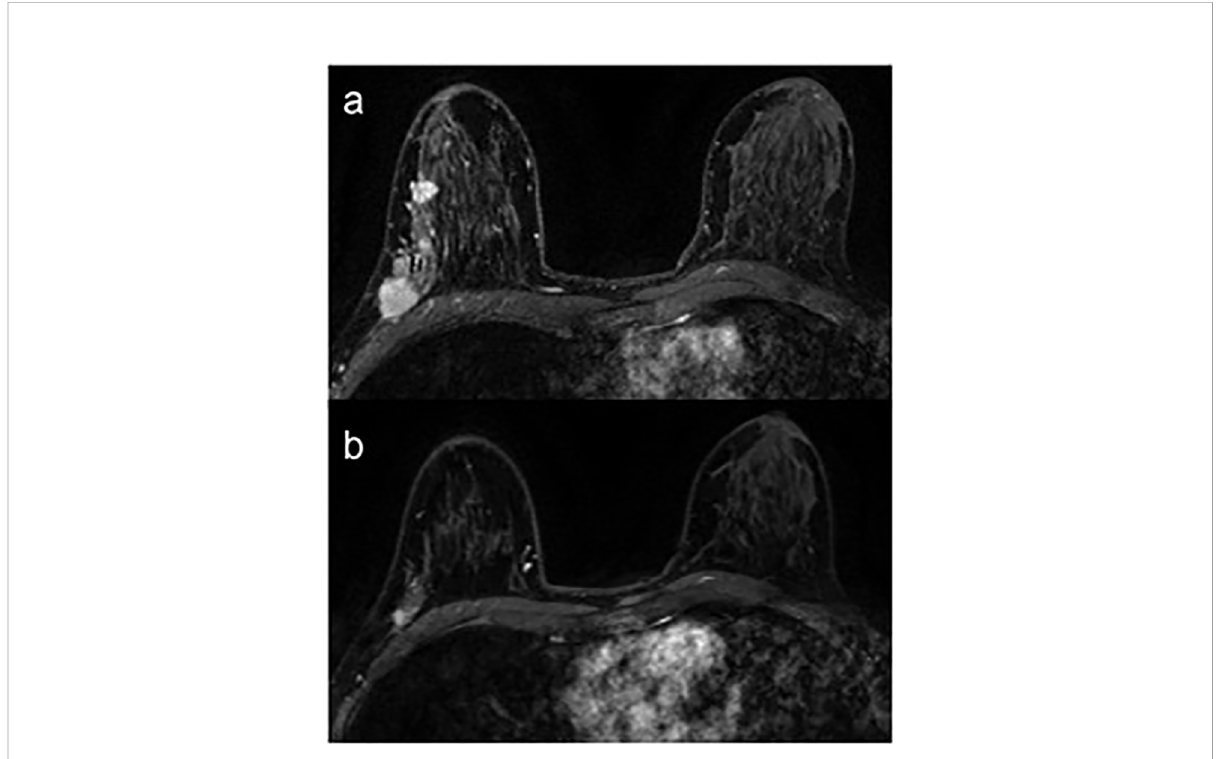
FIGURE 2 Breast MRI of a 53-year-old obese woman (VAT = 152.8 cm 2 ; VAT > 130 cm 2 = visceral obesity) with a multifocal breast cancer of the right breast. Axial post-contrast T1-weighted images before (A) and after (B) 6 months of CDK 4/6 inhibitors show a good response to treatment, as documented by the reduction in size of all lesions in the upper-outer quadrant/axillary extension of the right